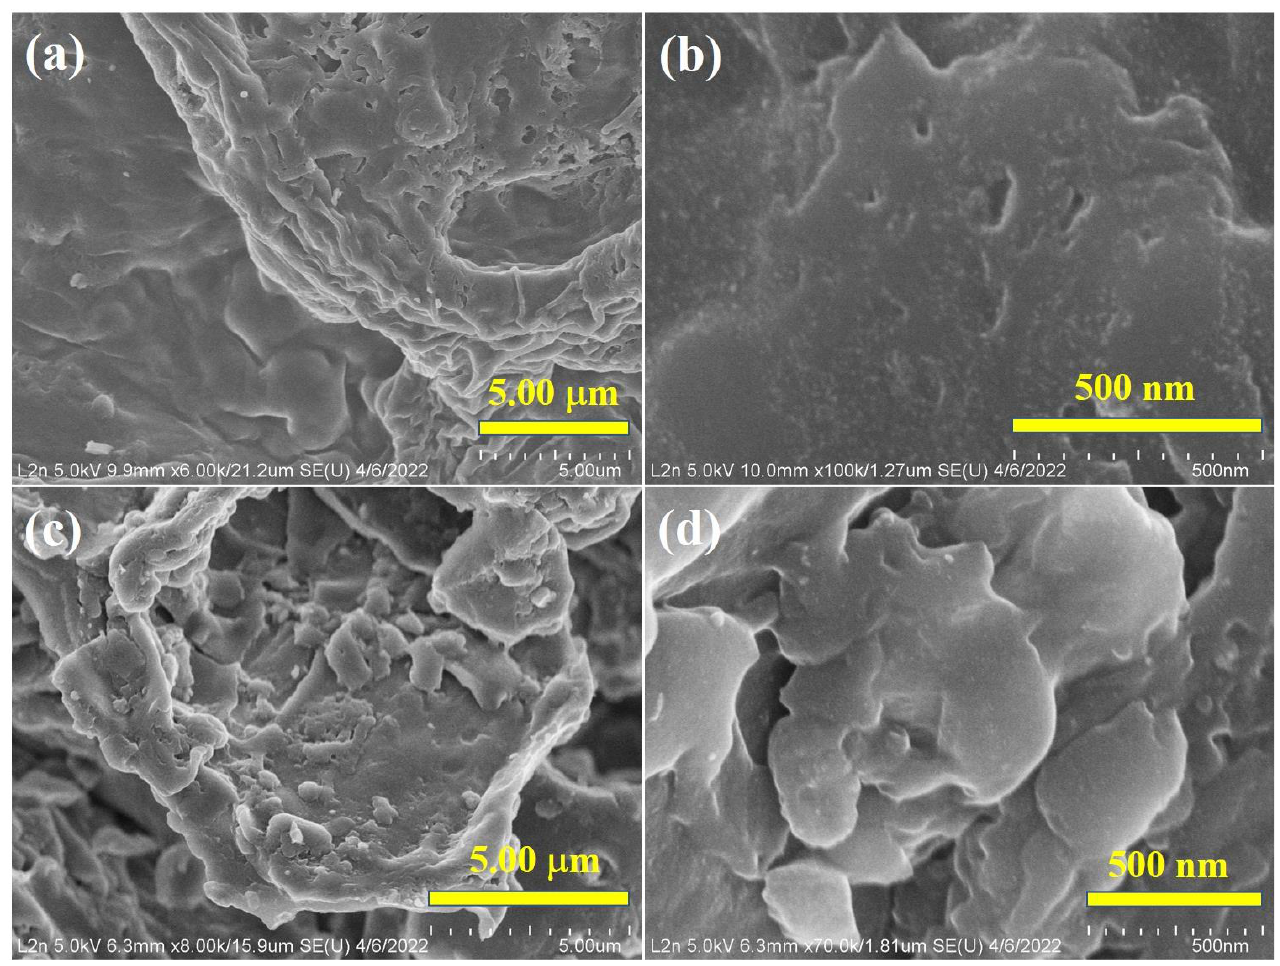
Figure 6. FESEM images of ( a , b ) B-SP and ( c , d ) B-SPCM.